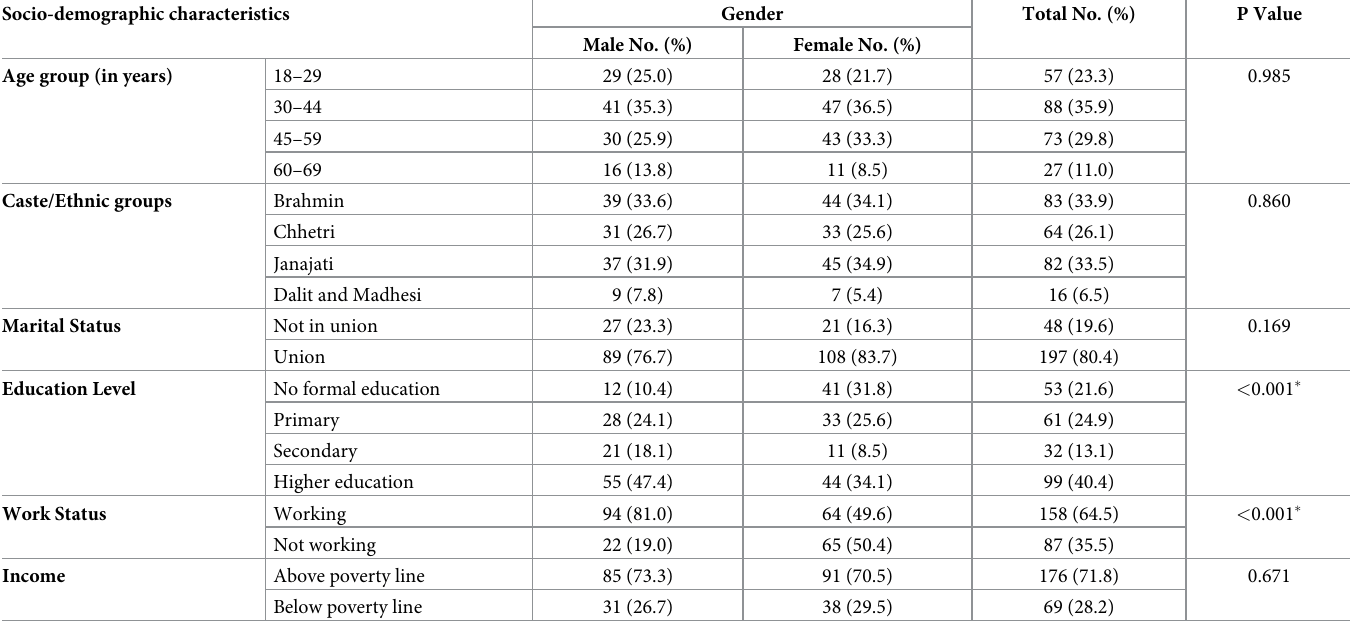
Table 1. Distribution of socio-demographic characteristics by gender (n =